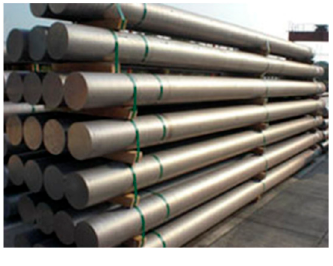
Figure 3. Aluminum alloy rods. Table 4. Adjusted 6063 aluminum alloy rods’ composition used by Company